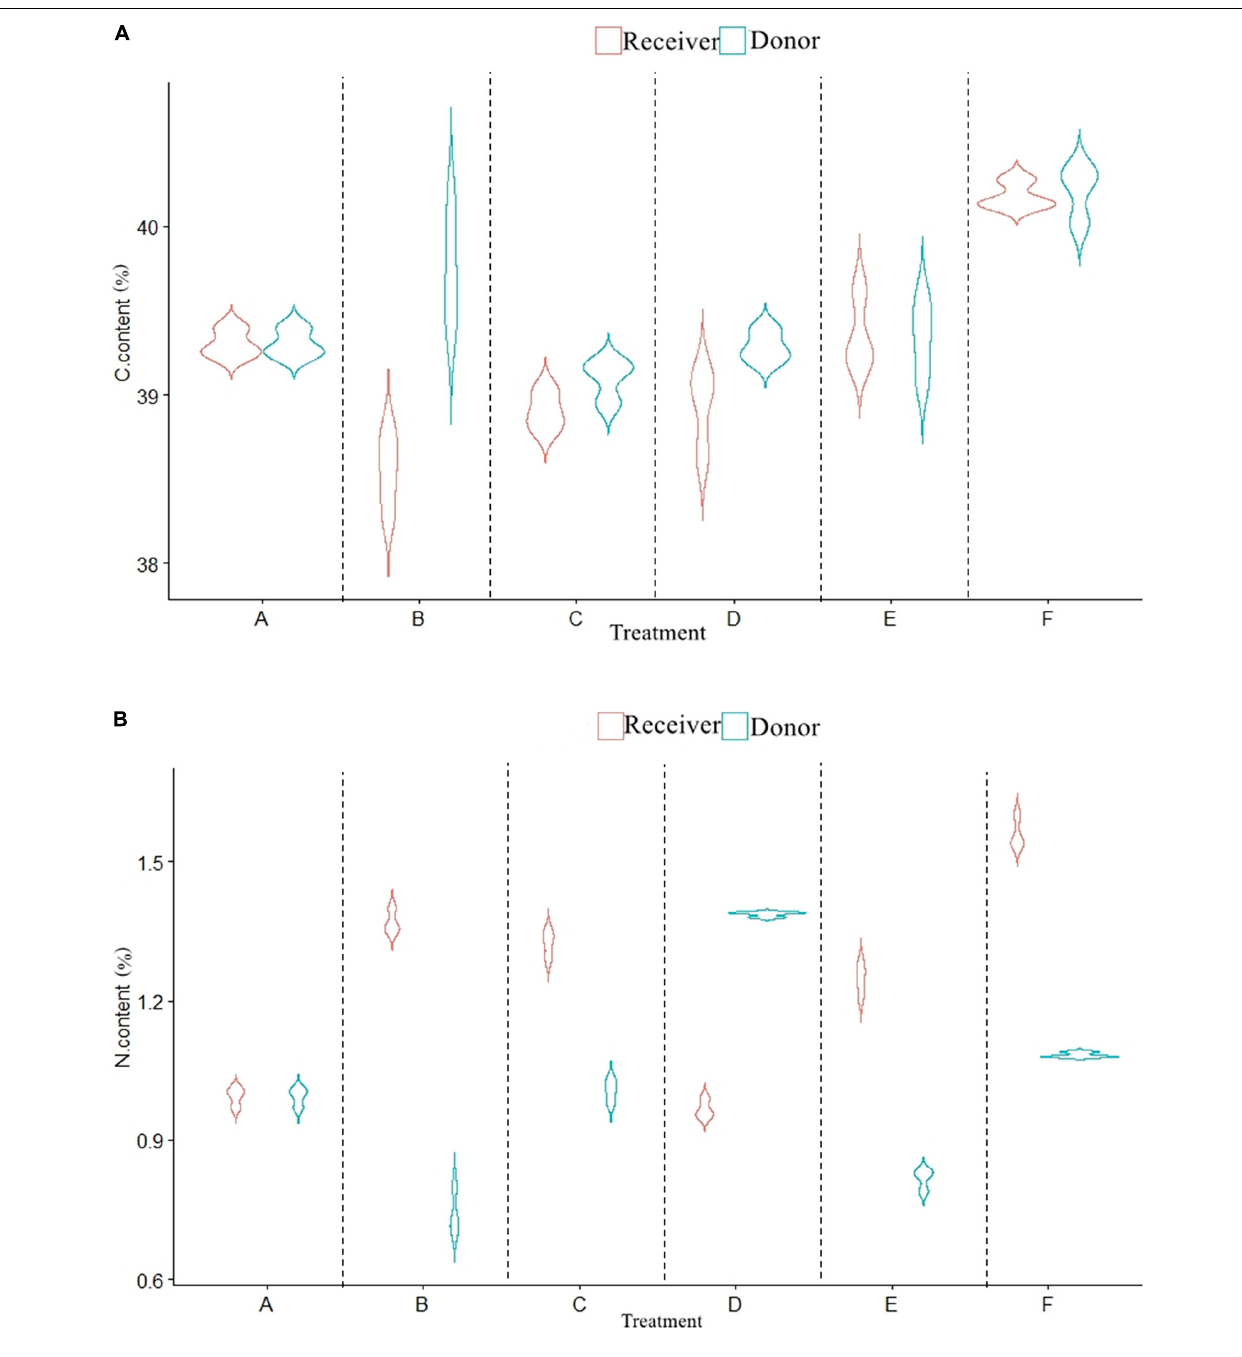
FIGURE 3 | Effects of AMF on C and N content of donor and receiver plants between different treatments. Data are mean ± SD (n =